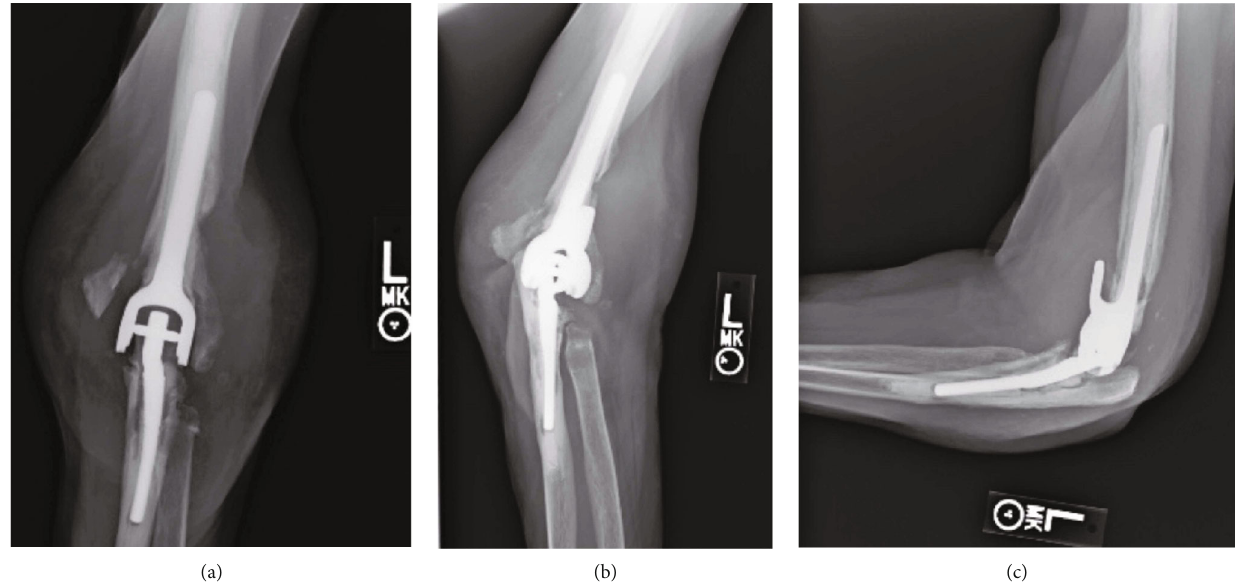
Figure 1: (a – c) Preoperative X-ray imaging of the operative left elbow showing prosthetic loosening and periprosthetic fracture. (a) AP imaging of the left elbow with new periprosthetic fracture of the medial epicondyle and signi fi cant soft tissue swelling. (b) Oblique imaging of the left elbow again demonstrating a periprosthetic fracture of the medial epicondyle and lucency around the lateral aspect of the humeral implant. (c) Lateral X-ray of the left elbow demonstrating both ulnar and humeral component lucency concerning for